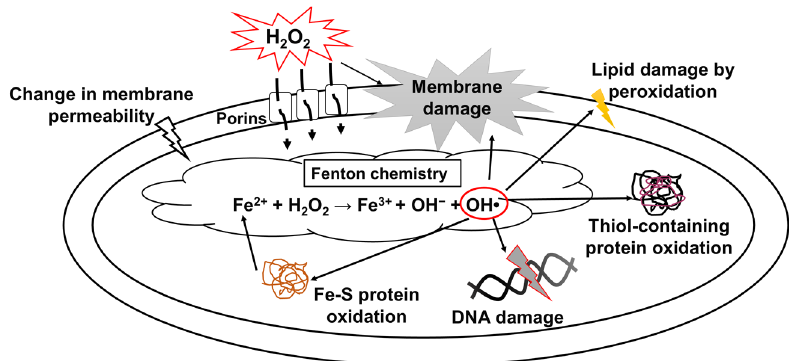
Fig. 5 Proposed mechanism for e-scaffold generated H 2 O 2 enhancing antibiotic susceptibility. H 2 O 2 generated extracellularly by e-scaffold diffuses through the bacterial cell envelope and reacts with intracellular Fe 2+ , forming radicals that oxidize lipids, proteins and DNA, which prompts cell death. Through membrane damage or changing membrane permeability, antibiotic penetration into the bacterial cell is increased, which in turn enhances the antibiotic susceptibility of the